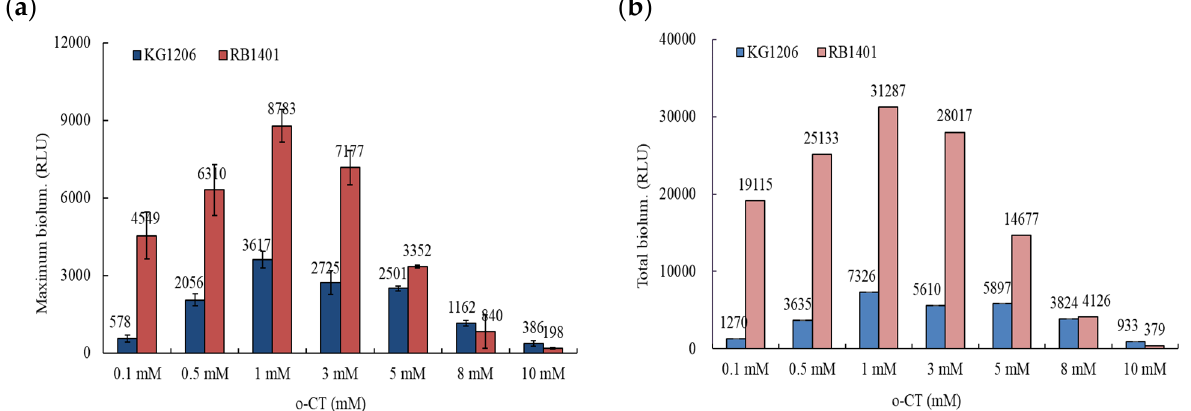
Figure 3. Comparisons of the bioluminescence activity between KG1206 and RB1401 exposed to various concentrations of o -CT: ( a ) maximum bioluminescence at each exposed concentration; ( b ) total bioluminescence production during 5 h incubation periods.